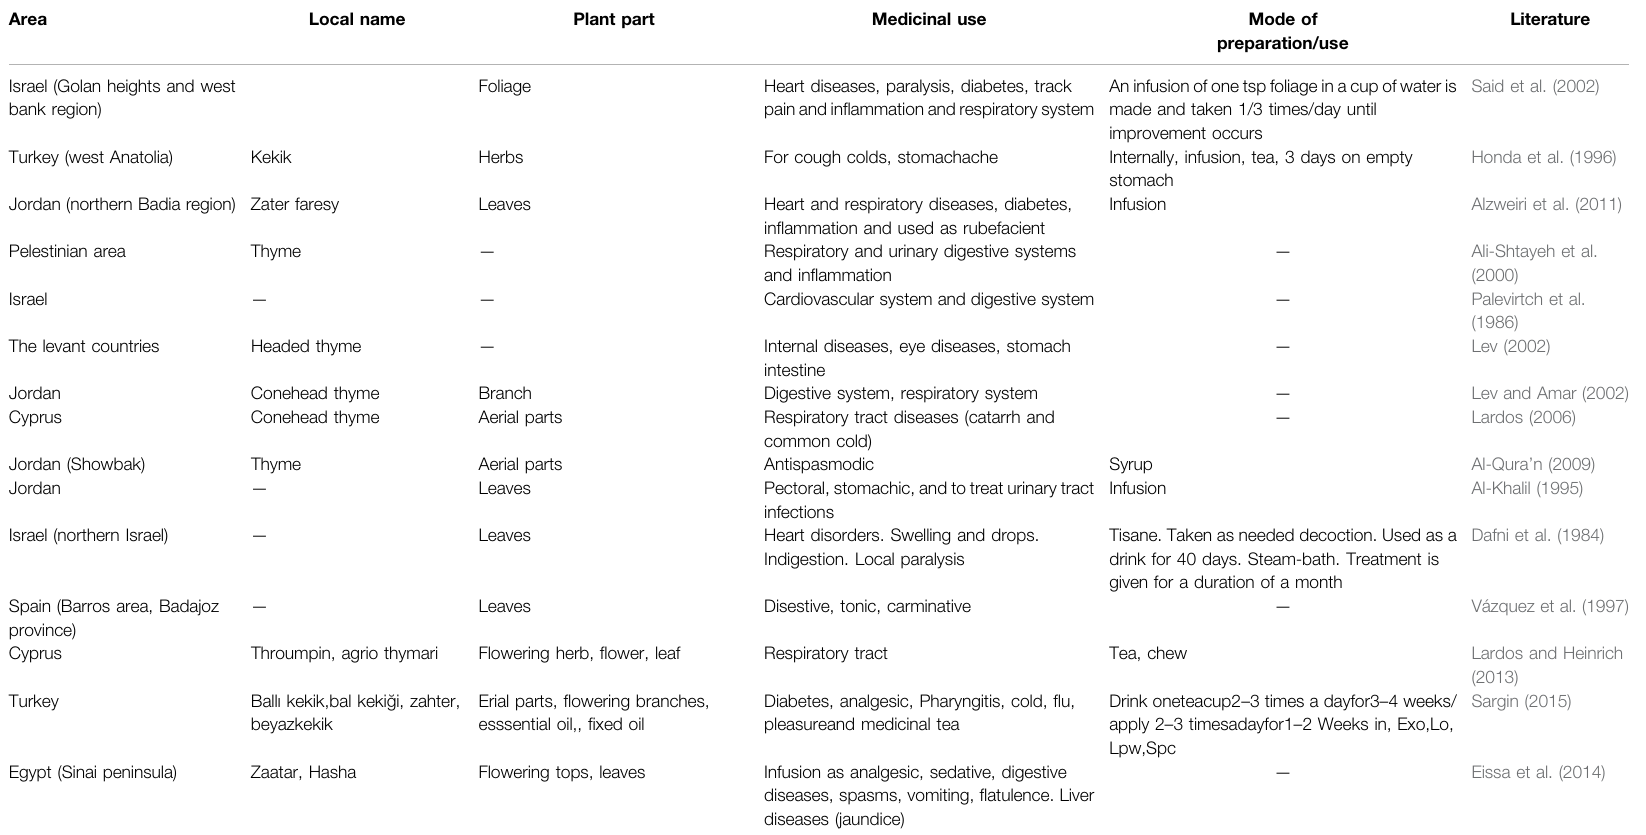
TABLE 1 | Medicinal uses of Coridothymus capitatus derived from ethnobotanical and ethnopharmacological